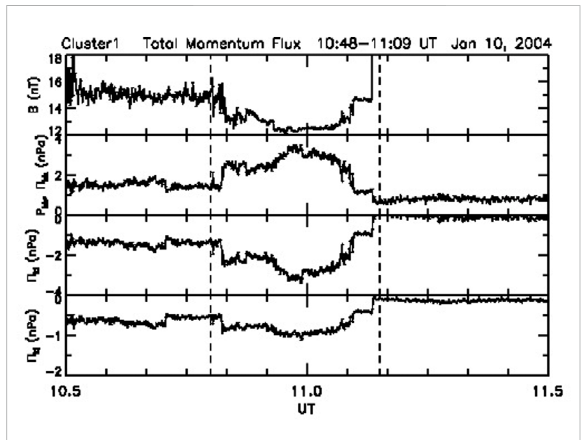
FIGURE 9 The pressure tensor based on Cluster 1 spacecraft data.From toptobottom,thetotal fi eldforreference,thetotalpressureinthe direction perpendicular to the CS at Cluster 1, (cid:5) kk , and the tangential stresses in the ith ( (cid:5) ki ) and jth directions ( (cid:5) kj